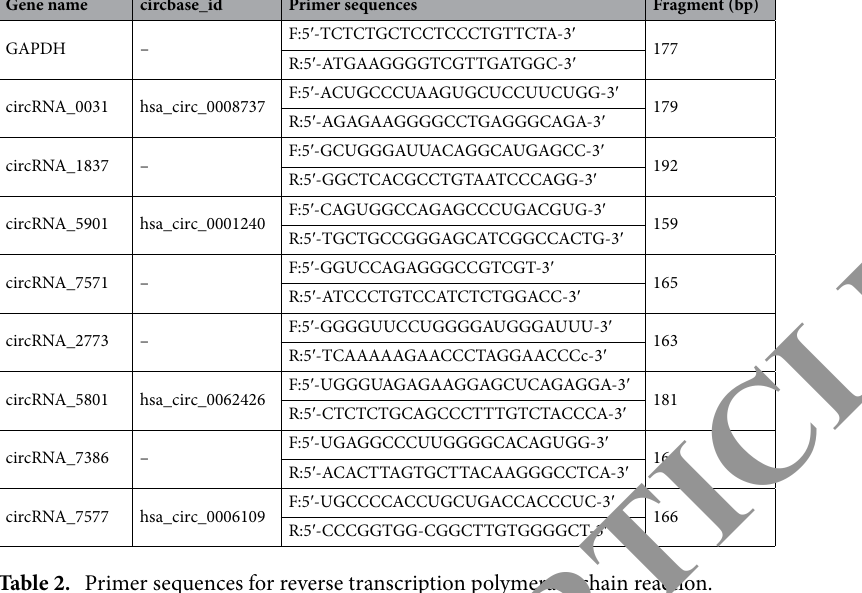
Table 2. Primer sequences for reverse transcription polymerase chain reaction.